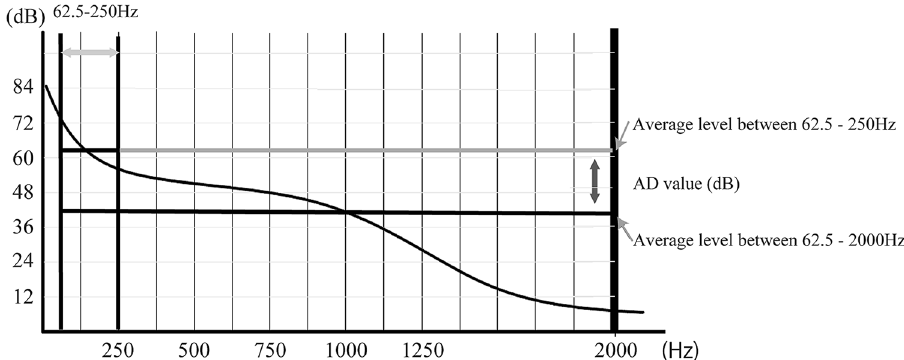
Figure 3. FFT analysis and calculation of AD values. The method to calculate AD values. Calculate the average value of 62.5–250 Hz and 62.5–2000 Hz bands. Then, subtract the average of 62.5–2000 Hz from the average of 62.5–250 Hz band. This value is defined as the AD value.